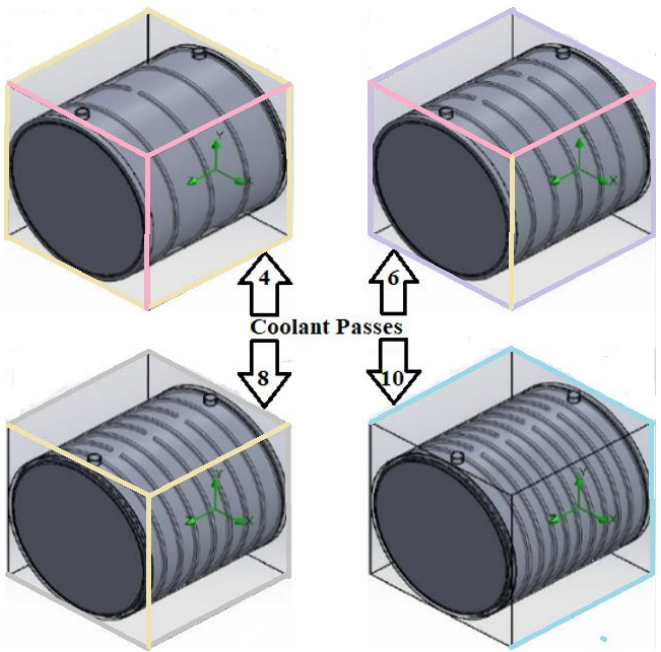
Figure 8. Cooling jacket configuration with different number of passes [40].